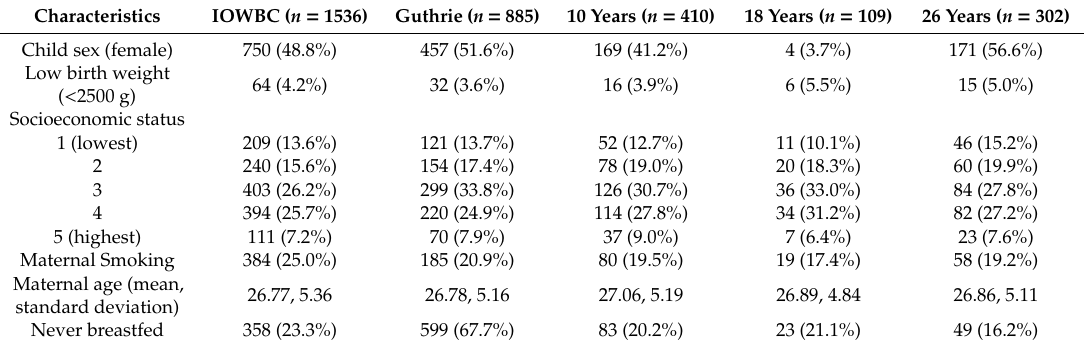
Table 1. Baseline characteristics of participants in the Isle of Wight Birth Cohort (IOWBC) with DNAm data at each time point.